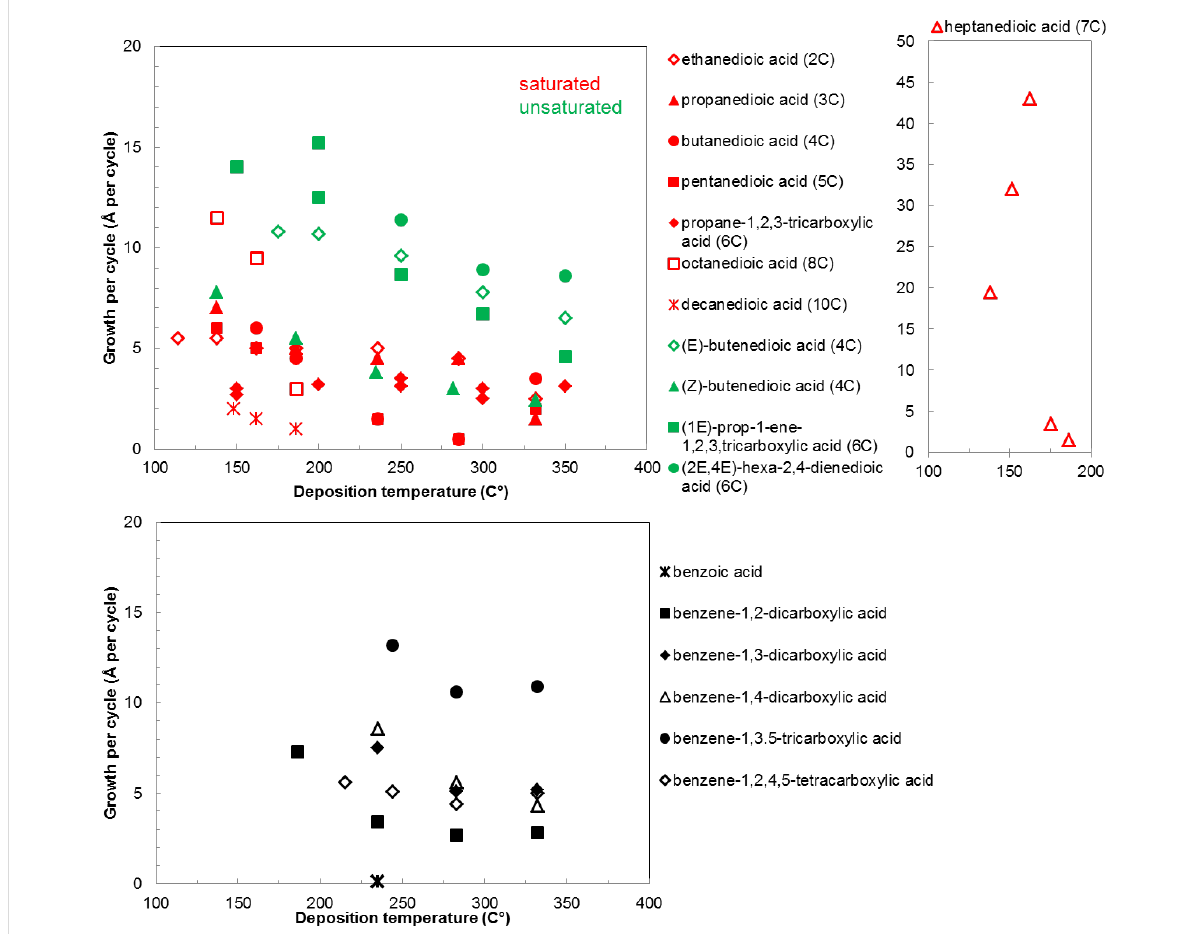
Figure 8: Growth per cycle values for inorganic–organic hybrid films deposited by using TMA with different carboxylic acids [32,57,110,112].